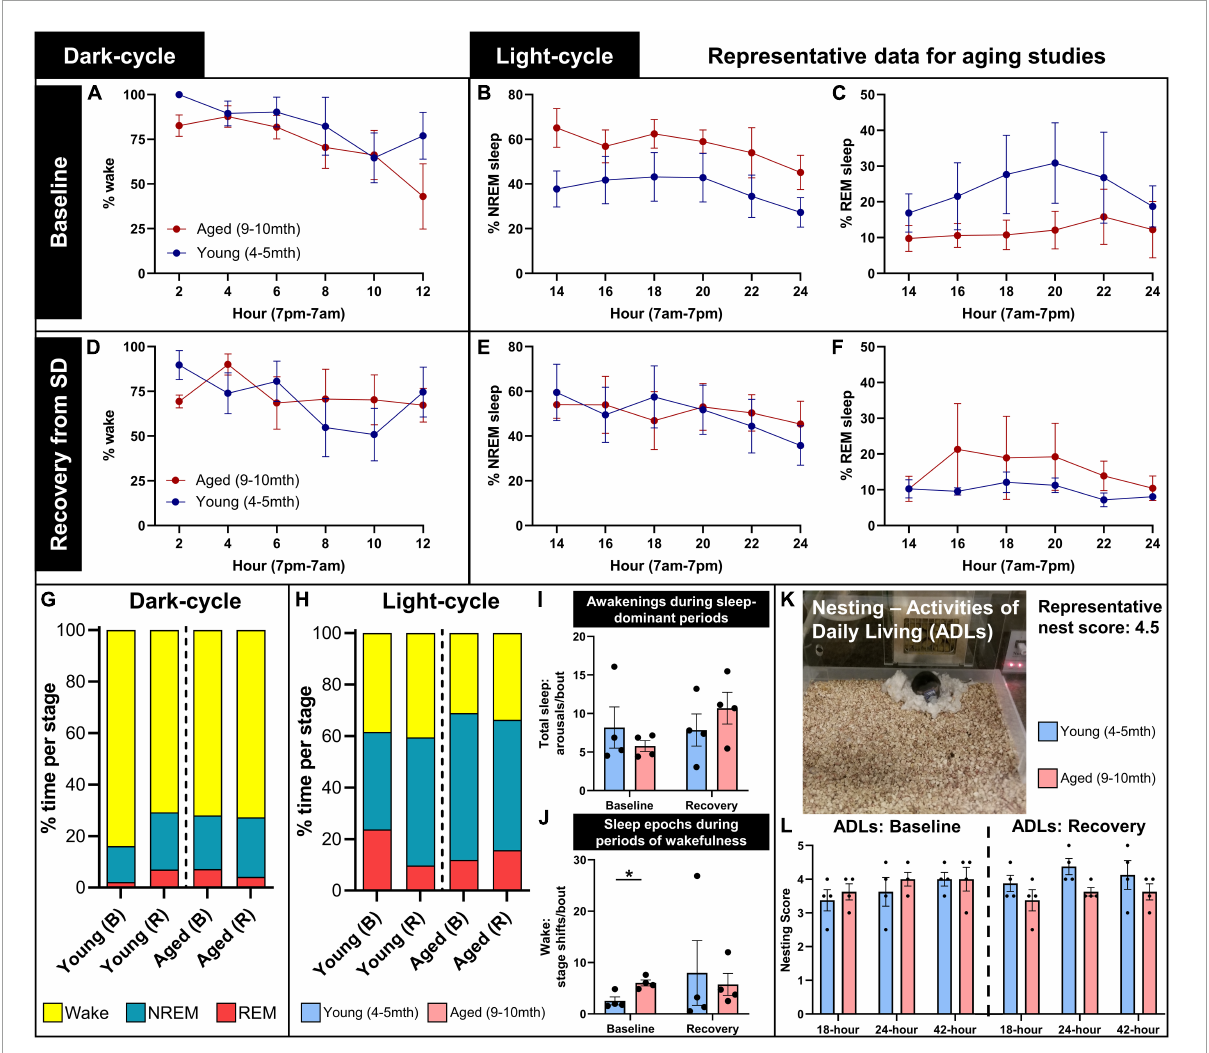
FIGURE6 Representative data for aging studies on sleep and home-cage assessments. Young (4–5 months; n = 4) and aged (9–10 months; n = 4) mice were recorded for a full circadian cycle in PhenoTyper home cages with EEG/EMG recording from wireless headcaps. Recordings were conducted at a baseline, and in a recovery period immediately following 6-h sleep disruption (SD), 1 week later (refer to Figure 2 for timeline). Sleep was staged as wake, NREM, and REM in 10-s epochs from EEG/EMG recordings, split into 12-h dark and light cycles and analyzed in 2-h intervals. (A) During the baseline dark cycle, young and aged mice spend a majority of their time awake, and start to sleep more near the onset of the light cycle. (B,C) During the baseline light cycle, young mice trend to less NREM and more REM sleep than aged mice. (D–F) In the recording period immediately following SD (indicated here as recovery), all mice trend to more sleep during dark-cycle, and young mice trend to more NREM and less REM sleep during light cycle, compared to baseline. (G,H) Summary of the distribution of wake (yellow), NREM (blue), and REM (red) in young and aged mice in baseline (B) and recovery (R) recordings, for dark- and light-cycles. (I) During light-cycle, no significant differences in sleep arousals were detected between young and aged mice at baseline and recovery; (J) however, aged mice exhibited significantly more sleep epochs during periods of wakefulness at baseline ( P = 0.022), indicating increased sleep fragmentation with age. (K,L) Nest building was scored at 18, 24, and 42 h as a measure of activities of daily living during baseline and in the post-SD recovery period, demonstrating the trend to reduced nest complexity in aged mice in the recovery period, compared with young mice ( P = 0.081). Data are mean ± SEM (A–F,I,J,L) and mean (G,H) . Multiple unpaired t -tests with multiple comparisons controlled with the Holm–Šídák method (I,J) ; two-way repeated measures ANOVA (L) . * P < 0.05.